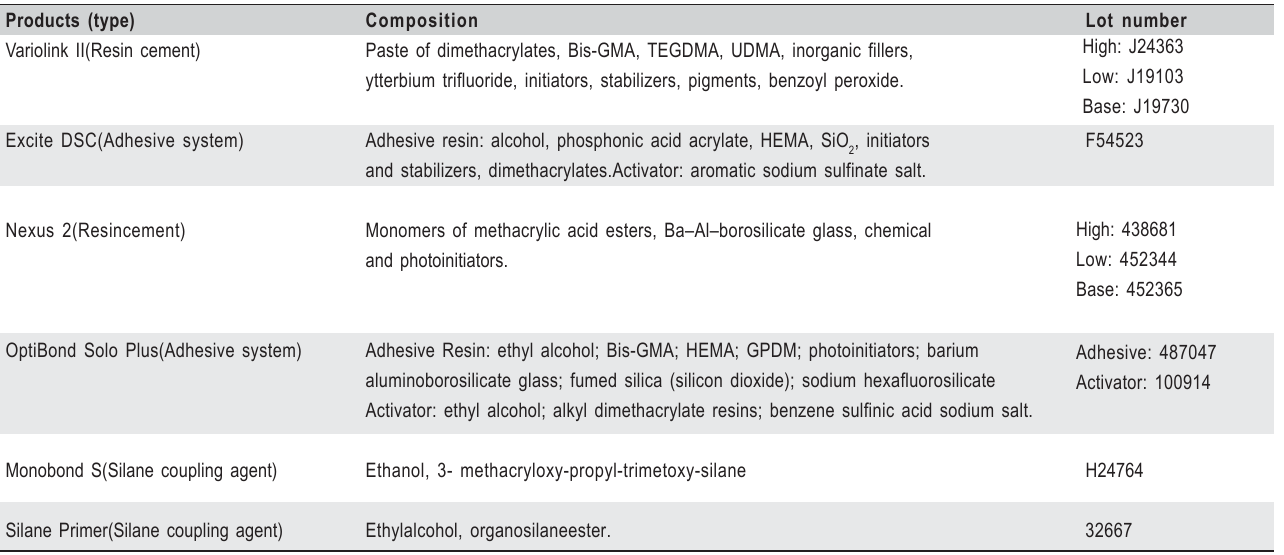
Table 1. Compositions of the resin cements used in this study.